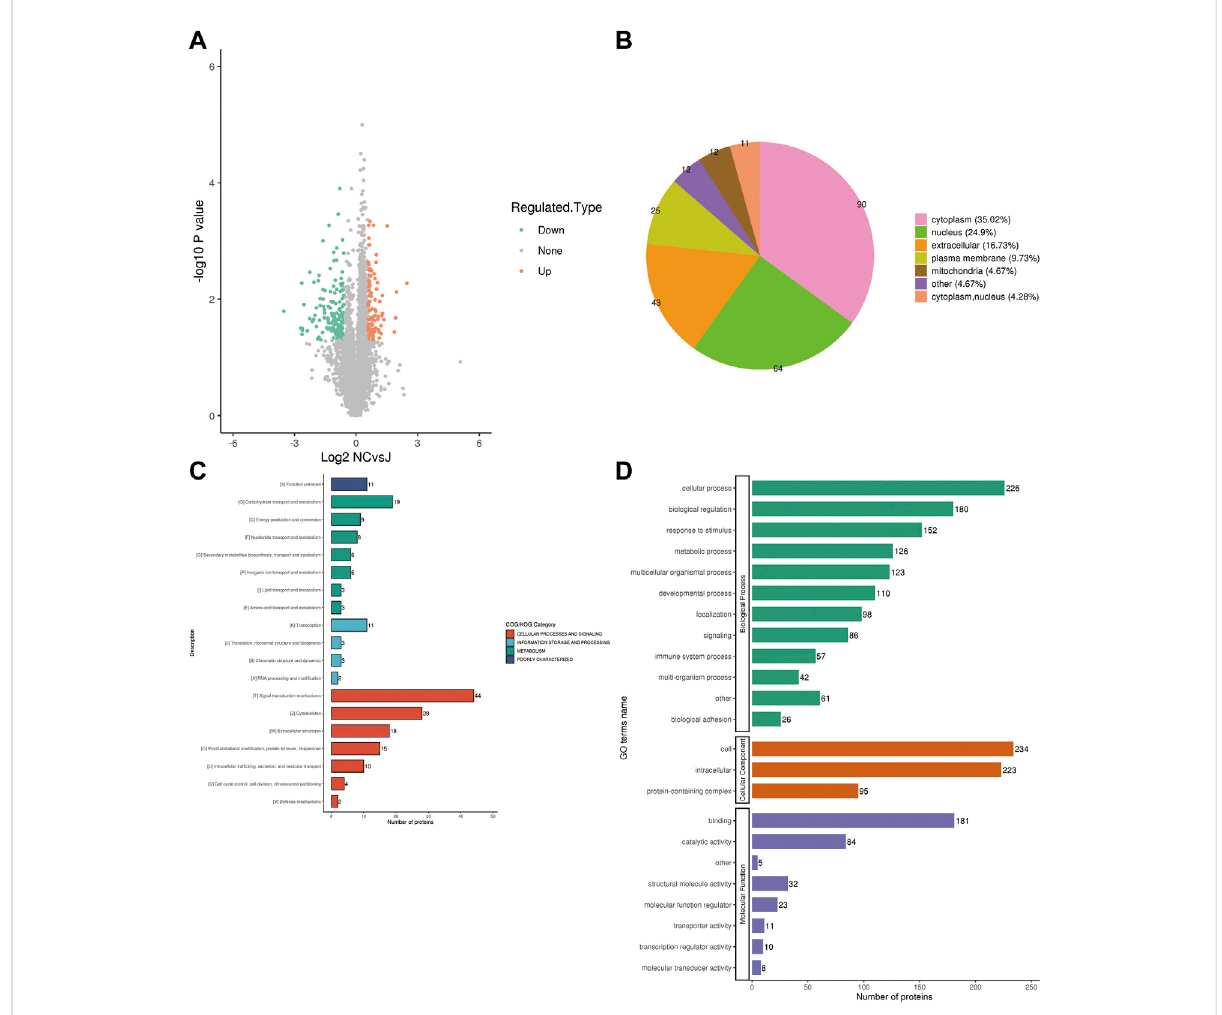
Figure 6. Some DEPs were enriched for “ protein activation cascade ” , “ cellular response to interleukin-6 ” , “ regulation of protein activation cascade ” , and “ response to interleukin-6 ”